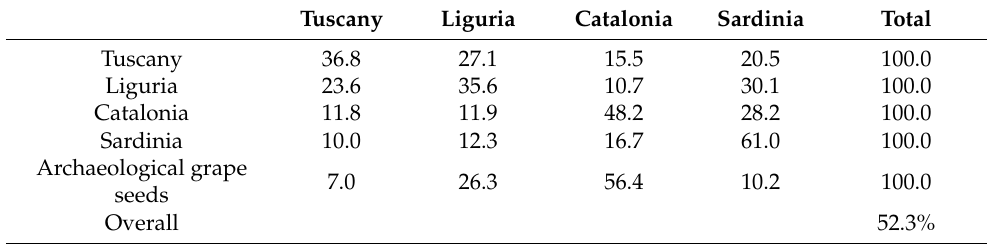
Table 4. LDA percentage results of comparison among the Middle Ages grape seeds, considered as unknown and four different modern cultivars groups considering their origin.